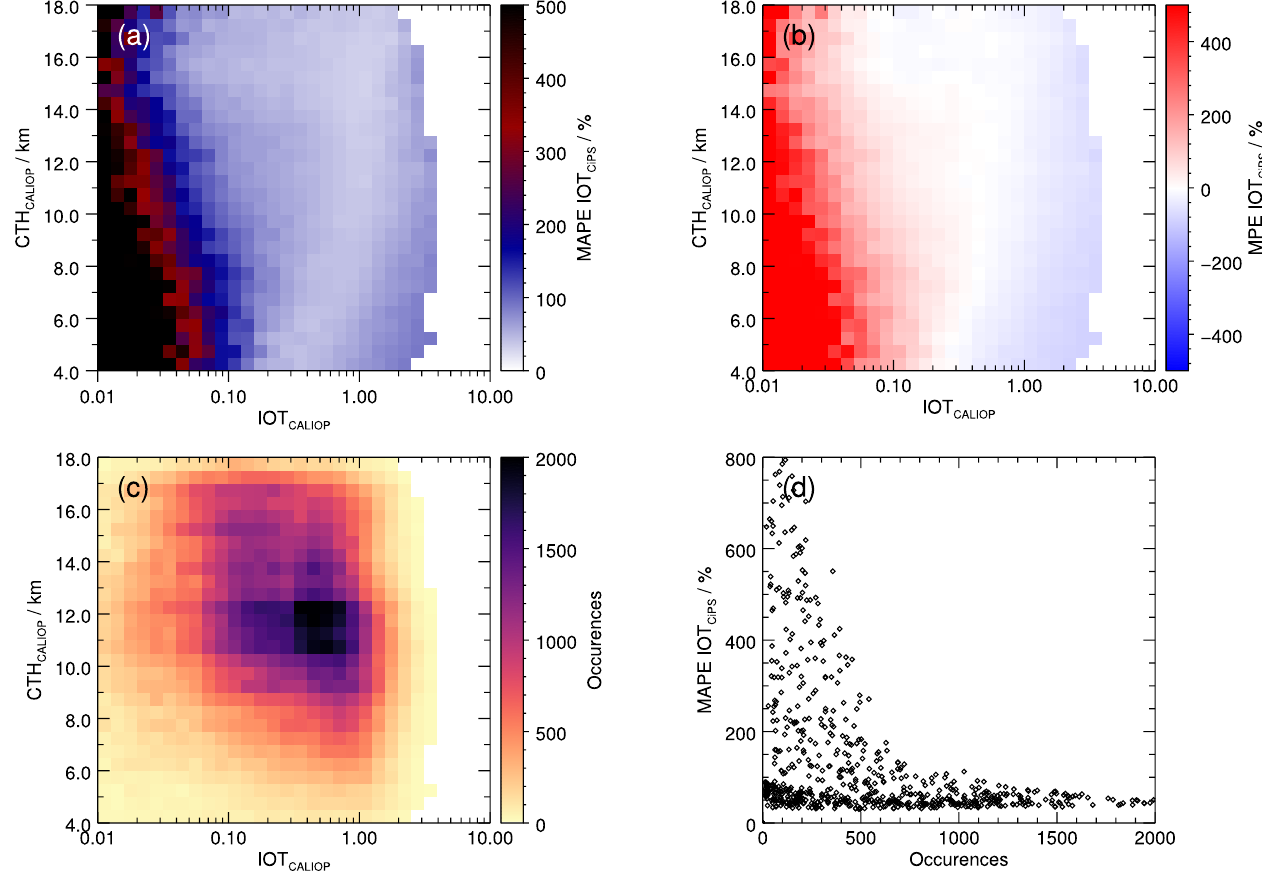
Figure 10. (a) Two-dimensional histogram showing the MAPE of the IOT CiPS retrievals as a function of the reference retrieval quantities IOT CALIOP and CTH CALIOP . (b) Two-dimensional histogram showing the MPE of the IOT CiPS retrievals as a function of IOT CALIOP and CTH CALIOP . (c) Two-dimensional histogram showing the number of occurrences for different combinations of IOT CALIOP and CTH CALIOP . (d) The MAPE of the IOT CiPS retrievals for the different IOT CALIOP / CTH CALIOP combinations as a function of the number of occurrences (each diamond represents two corresponding grid boxes in a and c